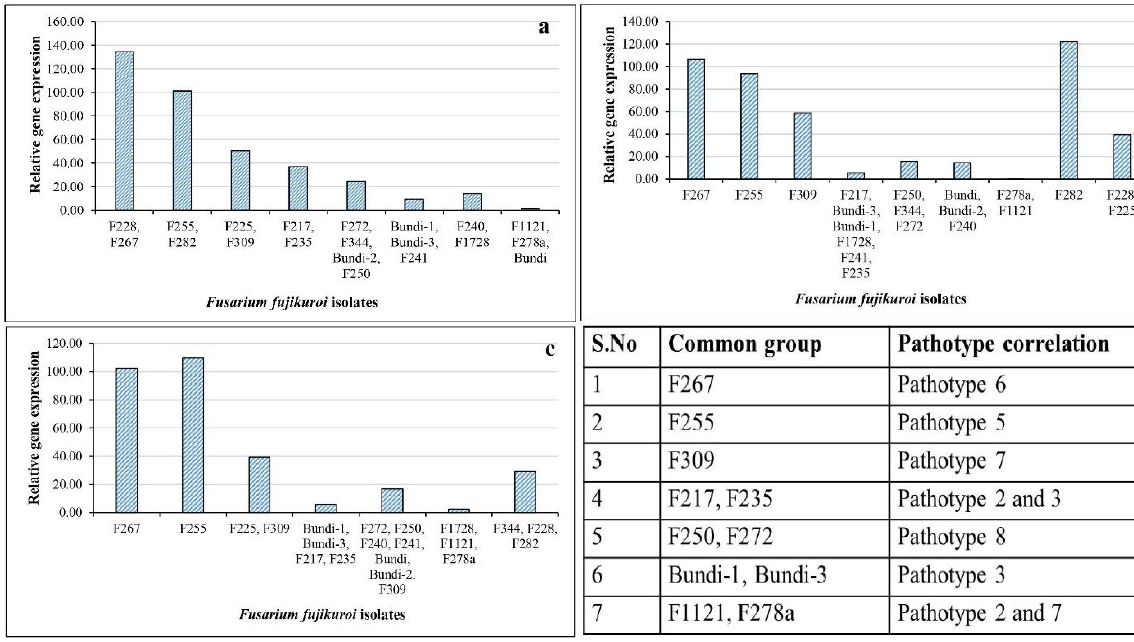
Figure 7. Grouping of Fusarium fujikuroi isolates based on virulence-related gene expression and pathotype correlation . ( a – d ) Grouping of isolates based on gene expression analysis: ( a ) acetylxylan ( FFAC ), ( b ) exoploygalacturanase ( FFEX ), ( c ) pisatin demythalase ( FFPD ), and ( d ) common groups were formed by comparing the isolates in all three genes and used for pathotype correlation. Patho- types 2 and 3, and pathotypes 2 and 7, were considered as single groups. In each gene, isolates showing similar fold change values were classified into groups and mean fold change values were used to plot the graph. In total, six pathotype groups have positive correlations with virulence-related gene expression analysis.